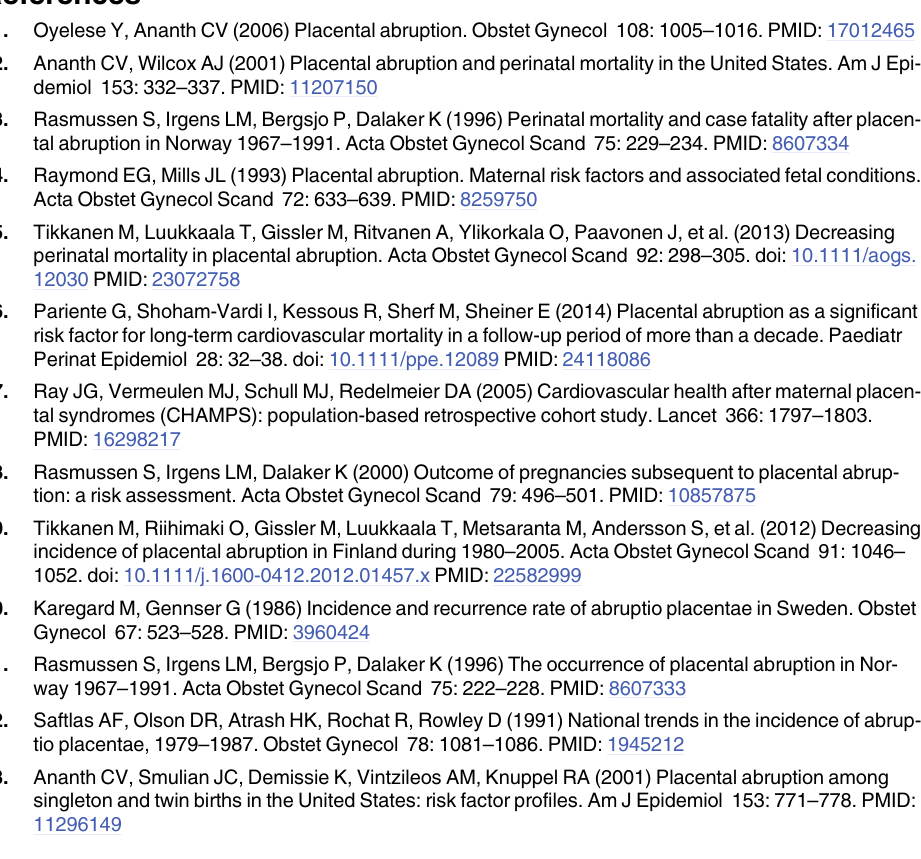
S1 Fig. Parameter estimates for smoking as a predictor of period effects for placental abruption in three countries: Sweden, United States, and Canada. S2 Fig. Age-period-cohort effects of placental abruption among White and Black women in the United